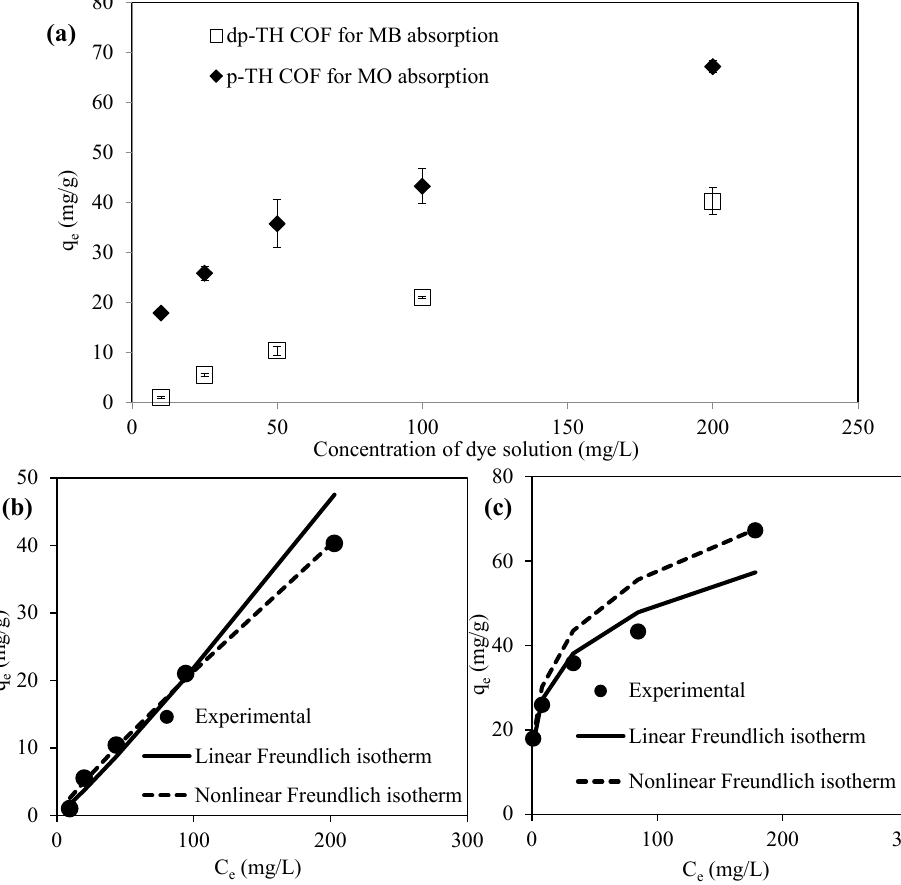
Figure 5. ( a ) Absorption of MB and MO dyes by dp-TH and p-TH at various concentrations of dye solutions, and curve fitting profiles of linear and nonlinear Freundlich isotherms to experimental results for ( b ) MB absorption by dp-TH, and ( c ) MO absorption by p-TH COFs. (Reaction conditions: 100 mL dye solutions at various concentrations, 0.05 g absorbent, 500 rpm, room temperature).